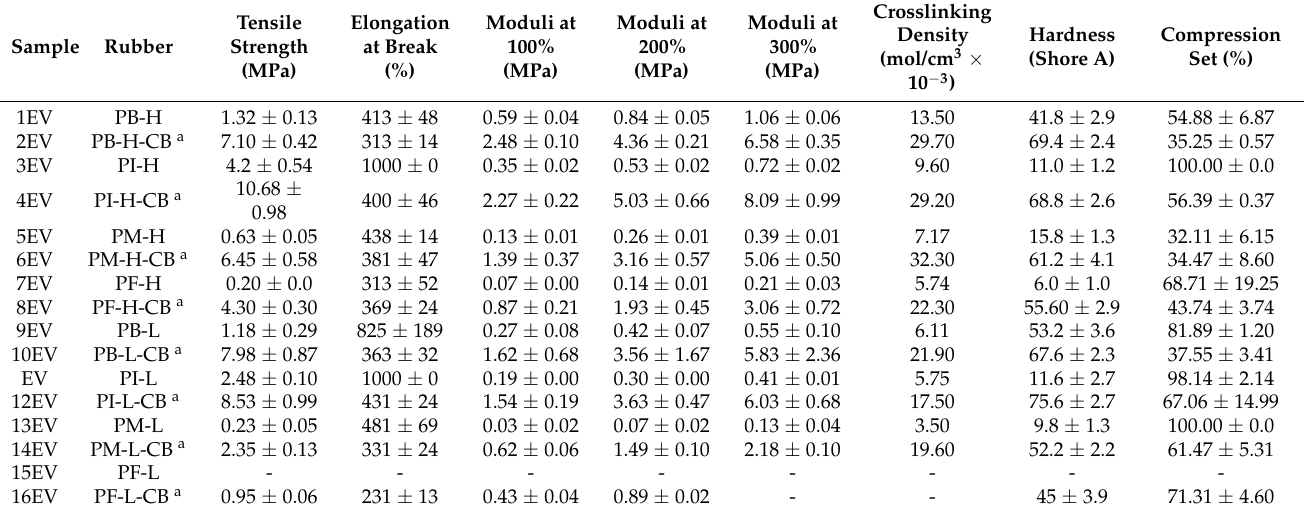
Table 4. The mean and standard deviation (mean ± SD) of the mechanical properties and crosslinking density of rubbers with the EV